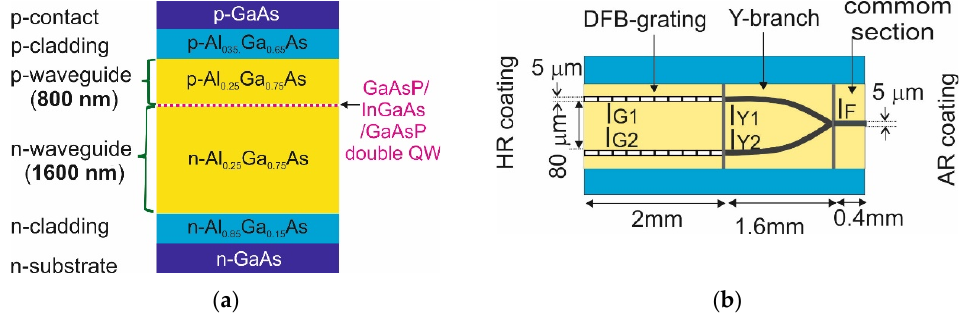
Figure 1. Epitaxial layer structure ( a ) and top view ( b ) of the Y ‐ branch DFB laser. The lateral–longitudinal structuring starts with the definition of 80 th order Bragg